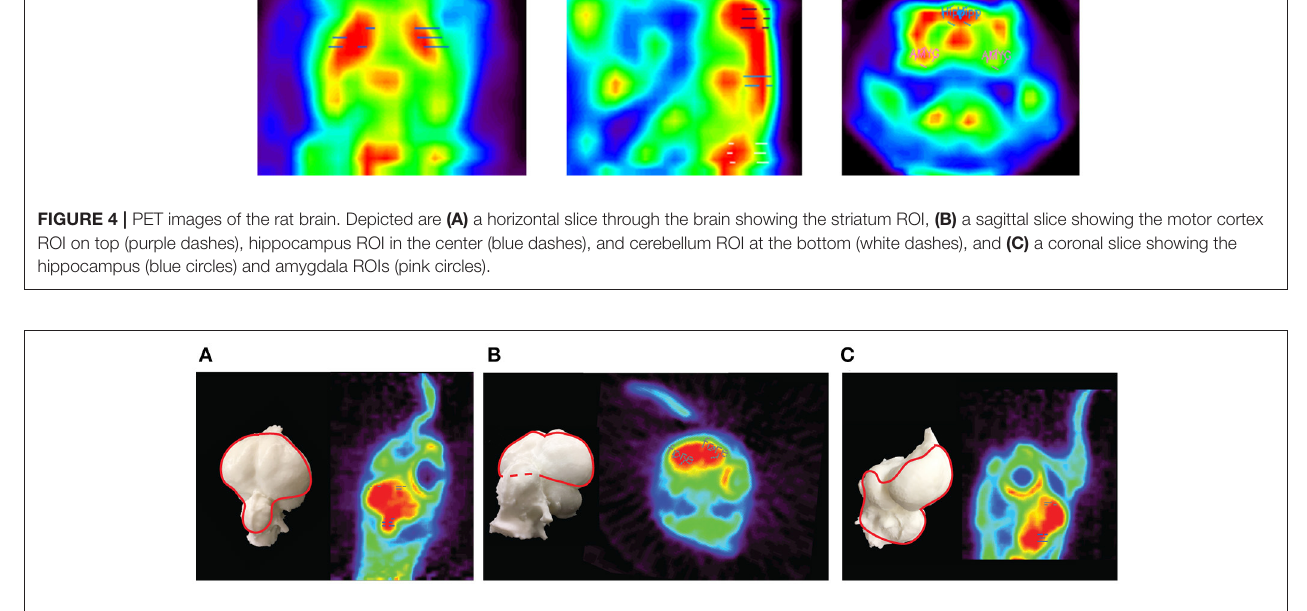
FIGURE 5 | PET images of the chicken brain. Depicted are PET images and corresponding endocasts of the chicken brain. The endocast is a 3-dimensional infilling of the cranial cavity that corresponds to the shape of the brain in a living animal, rotated to be in the same orientation as each PET image. (A) A dorsal oblique horizontal slice showing the forebrain (gray dashes) and the cerebellum (blue dashes) ROIs. (B) An oblique coronal slice showing the forebrain ROI. (C) A sagittal slice showing the forebrain and cerebellum